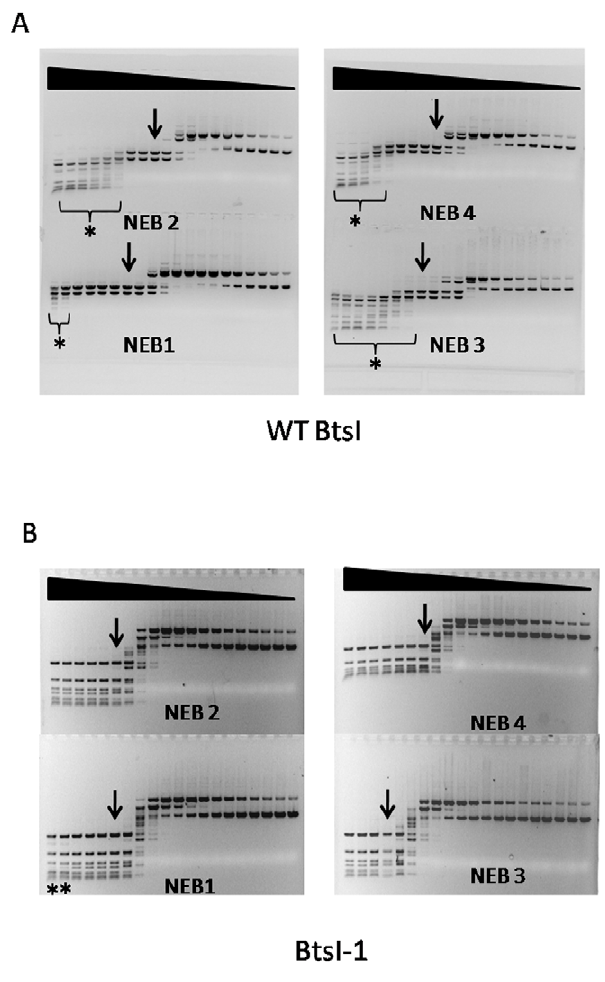
Figure 6. Comparison of relative activity between BtsI and BtsI- 1 in NEB1, NEB2, NEB3 and NEB4. Wild type BtsIB ( , 28 pmol) (A) or BtsIB-1 (20 pmol) (B) was mixed with same amount of BtsIA, 2-fold serially diluted and used to digest pUC19 (0.6 m g) for 1 hour at 55 u C in NEB1, NEB2, NEB3 or NEB4. Stars (*) indicate that star activities appeared at these concentrations. Arrows indicate the lane with complete digestion pattern with minimal protein concentration.